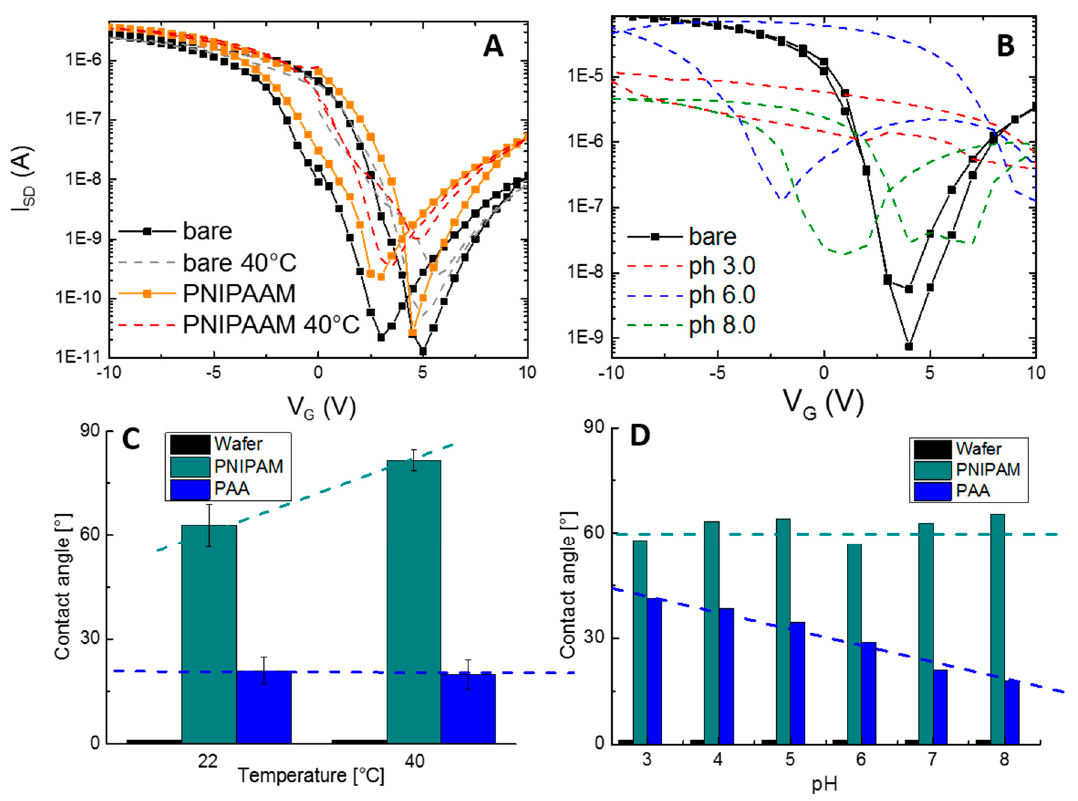
Figure 3. ( A ) Transfer characteristics of SiNW FETs with and without functionalization with PNIPAAM. Sensor response upon temperature increase above the lower critical solution temperature (LCST) is shown. There is no significant change in behavior from PNIPAAM-coated FETs compared to untreated devices, and brushes switch only under liquid conditions. ( B ) Transfer characteristics for unmodified and PAA-functionalized sensors upon immersion in three di ff erent pH solutions. With increasing pH, the chains of the brushes repel more to each other, leading to a growing gating behavior of the FETs. ( C ) Contact angles (CAs) of both brush systems upon temperature increase to 40 ◦ C. For PNIPAAM, hydrophobicity increases when T > LCST. ( D ) Contact angles of both brush systems upon change of surrounding pH. Static CA declines linearly for PAA-modified surfaces when pH is raised due to phase transition.